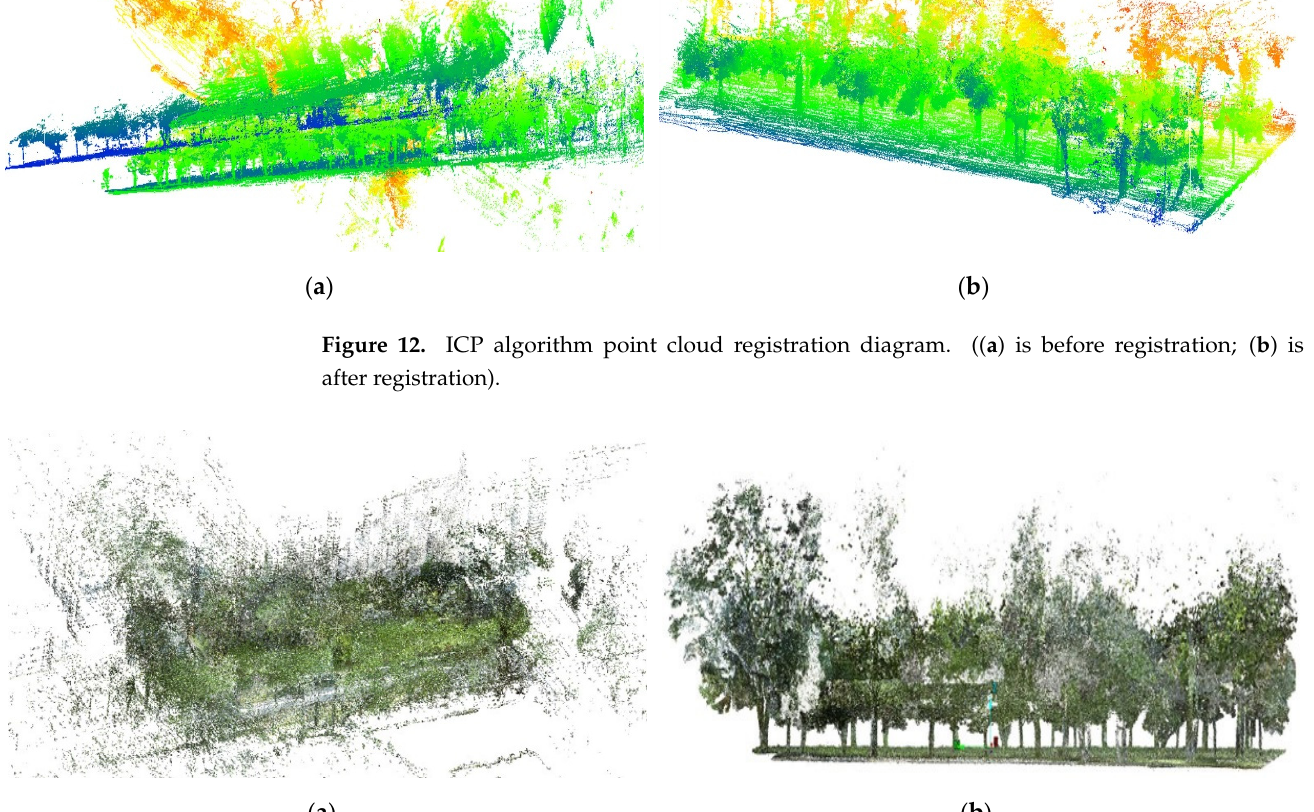
Figure 12. ICP algorithm point cloud registration diagram. (( a ) is before registration; ( b ) is after registration).